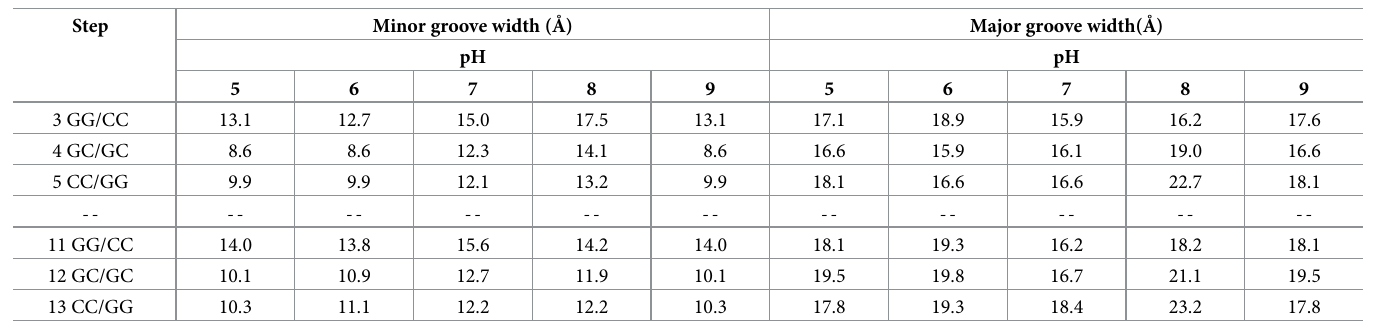
Table 1. Minor and major groove widths (direct P-P distances) [50] at 100K and various pH values.